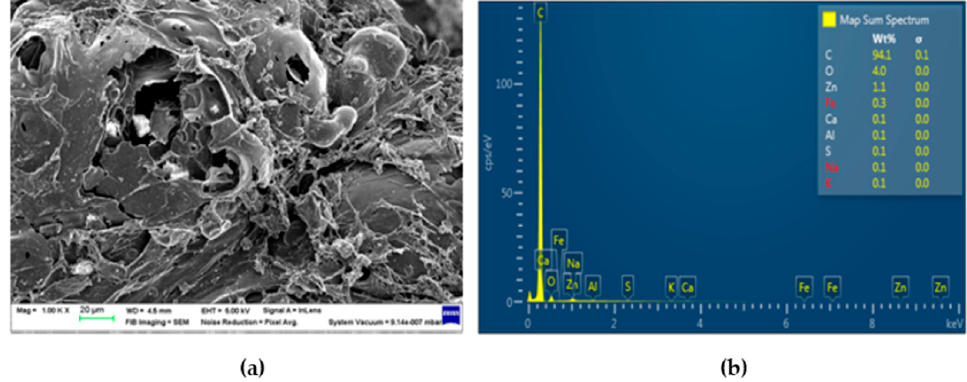
Figure 4. SEM image of AcHc ( a ) and corresponding elemental chemical analysis, EDX ( b ).